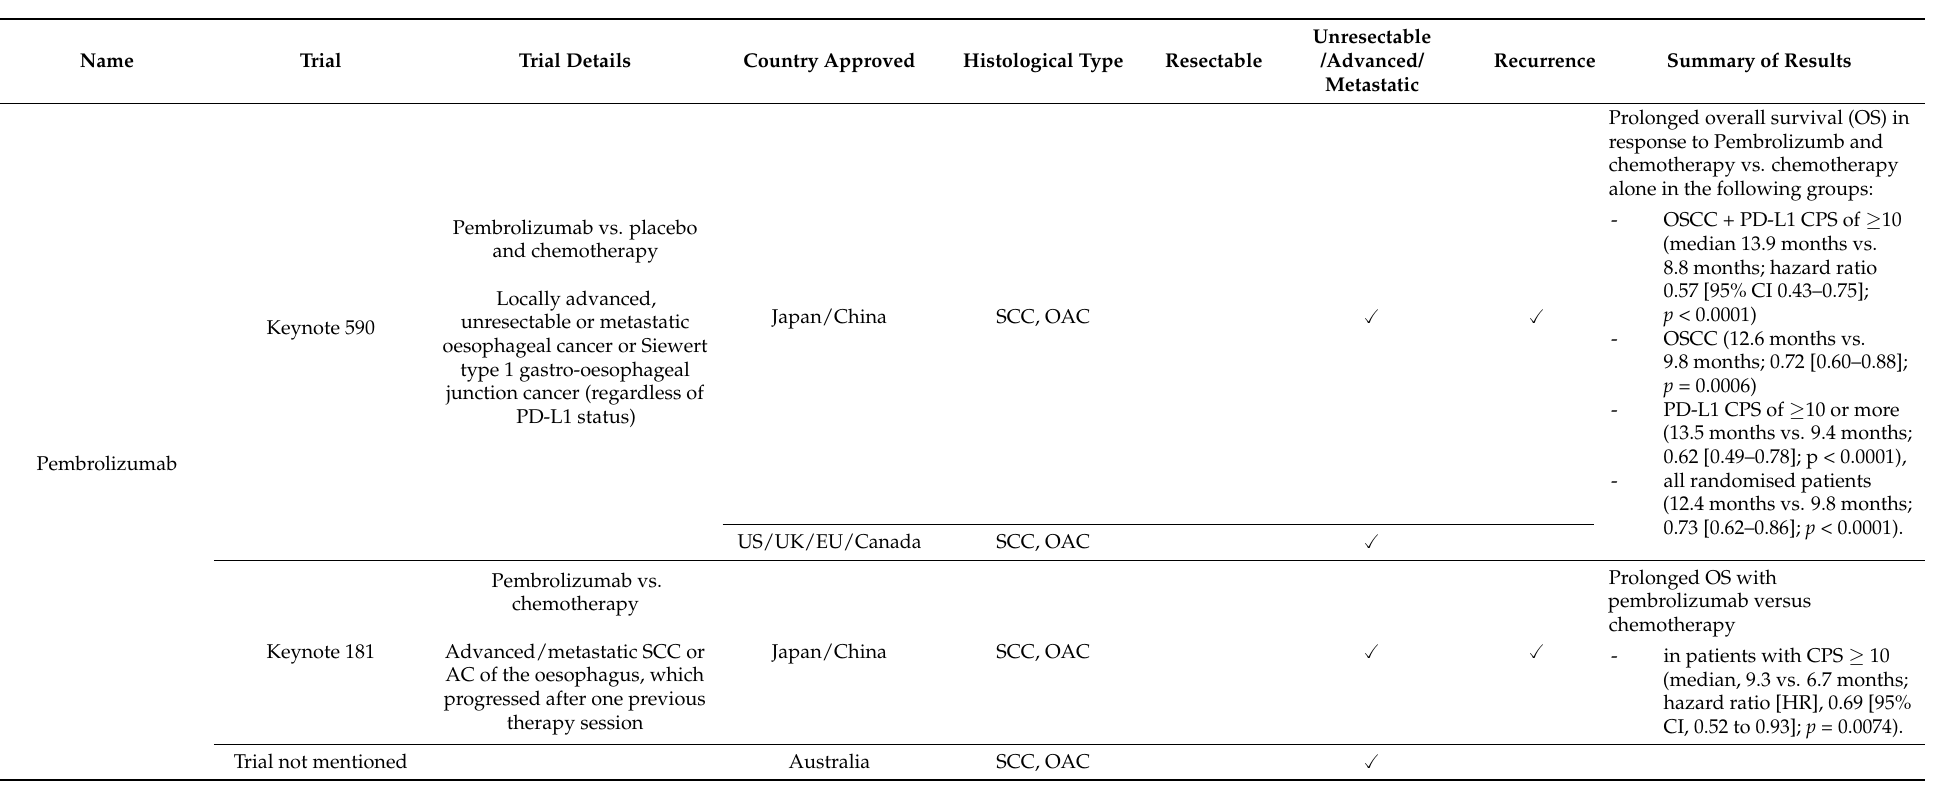
Table 1. PD1/PDL therapeutic agents approved worldwide for oesophageal cancer. (GOJ cancers included unless the trial specifically stated Siewert classification III or gastric